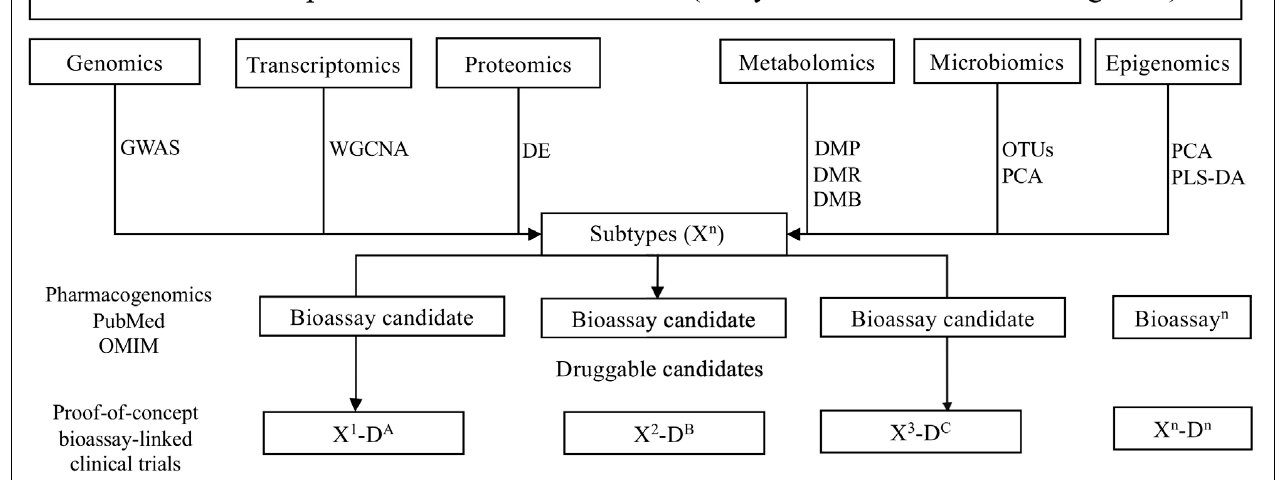
FIGURE 2 | Overview of the pipeline to ascertaining biologically suitable subpopulations for drug repurposing. GWAS, genome-wide association study; WGCNA, weighted correlation network analysis; DE, differential expression analysis; DMP, differential methylation probe; DMR, differential methylation region; DMB, differential methylation block; PCA, principal component analysis; PLS-DA, partial least squares discrimination analysis; OUTs, operational taxonomic unit.